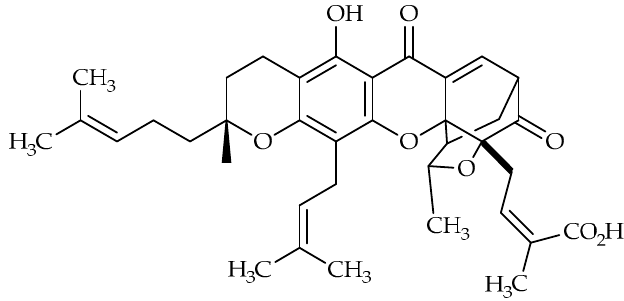
Figure 3. Gambogic acid ( 5 ) chemical structure.